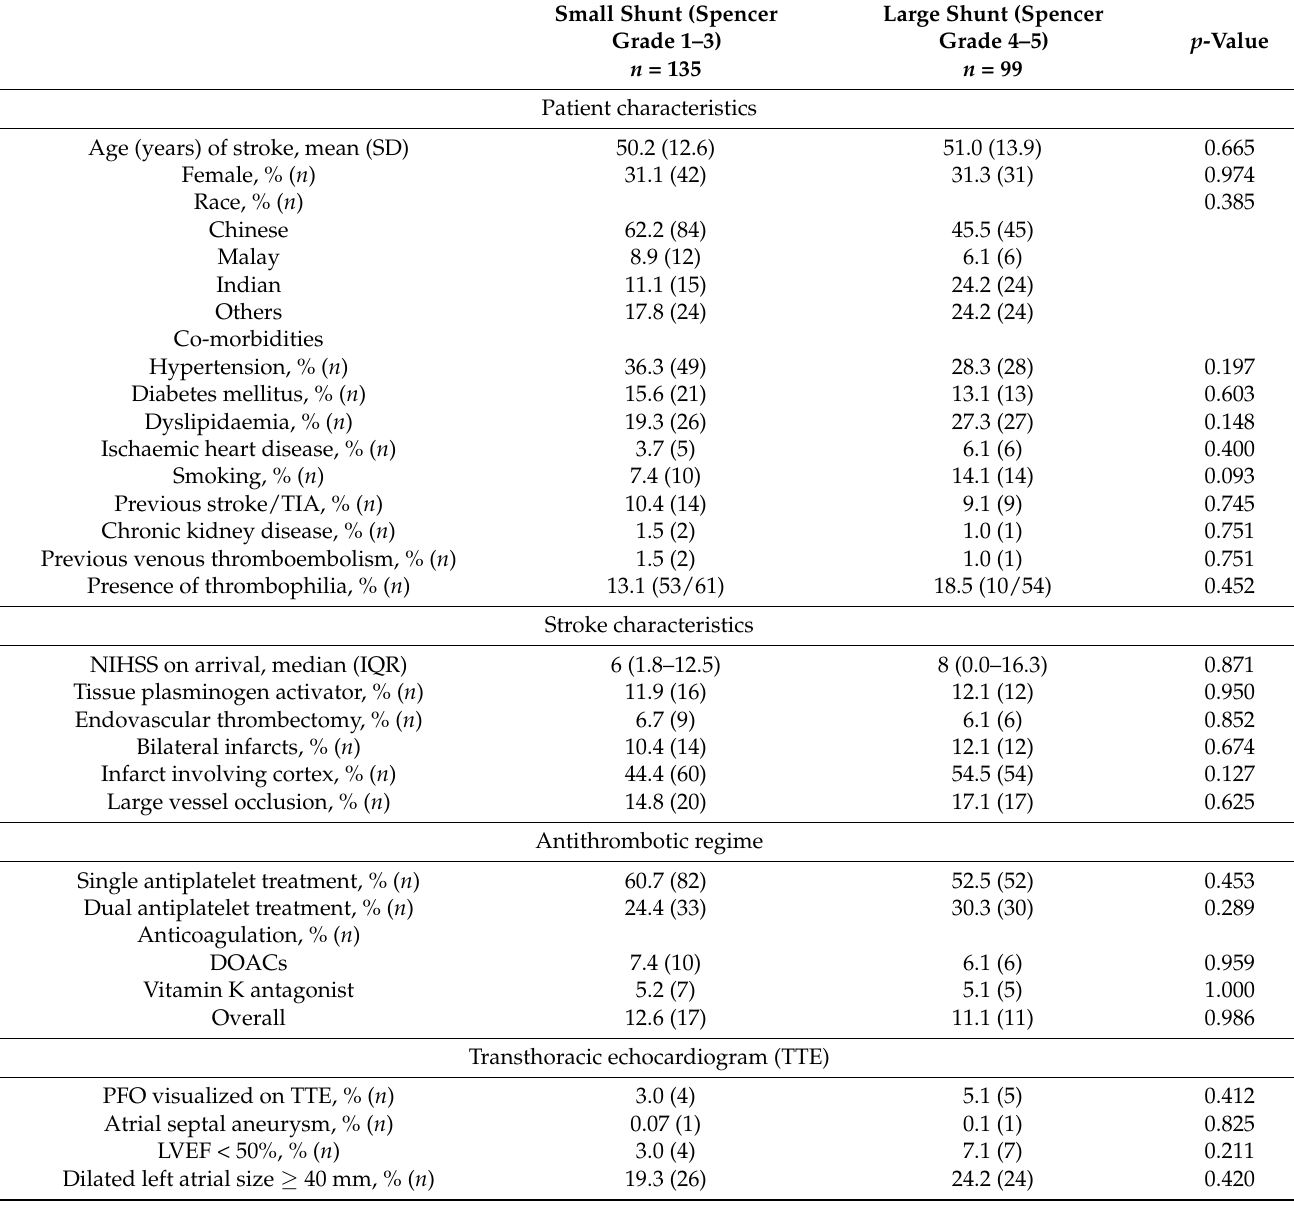
Table 1. Characteristics of PFO patients with small and large